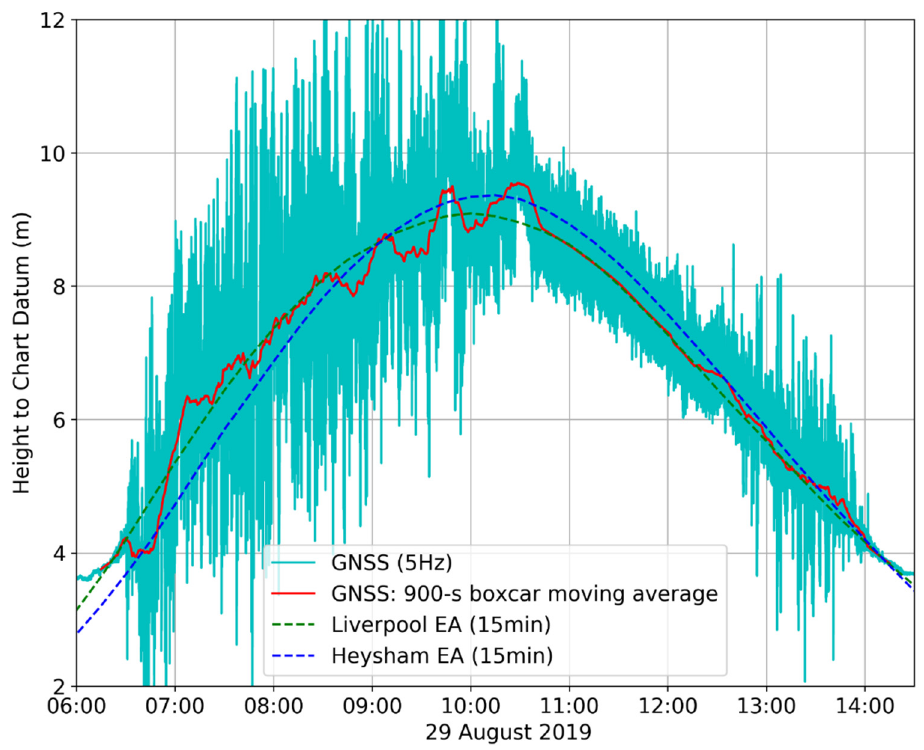
Figure 11. Comparison of the GNSS buoy derived sea levels for tidal cycle B and established tide gauges at Liverpool and Heysham. Note: after high water the 900 s boxcar moving average can be seen to match the 15 min Liverpool tidal data.